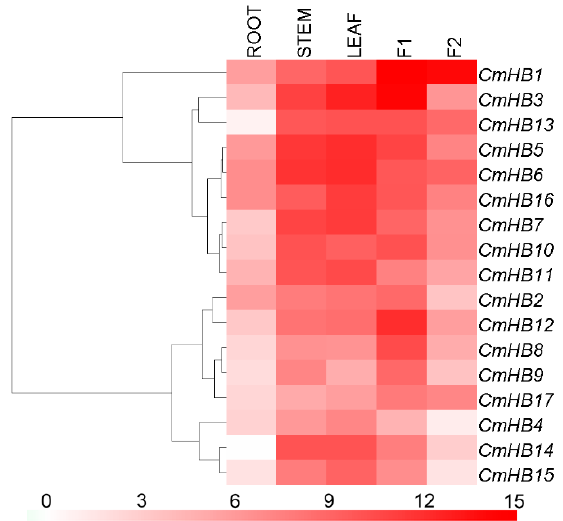
Figure 3. Differential transcription of CmHB genes. F1, tubular florets; F2, ray florets at the budding stage. White and red indicate lower and higher transcript abundance, respectively. The relative expression levels of each CmHB gene were log2 transformed, the lowest expression level was defined as control (zero).